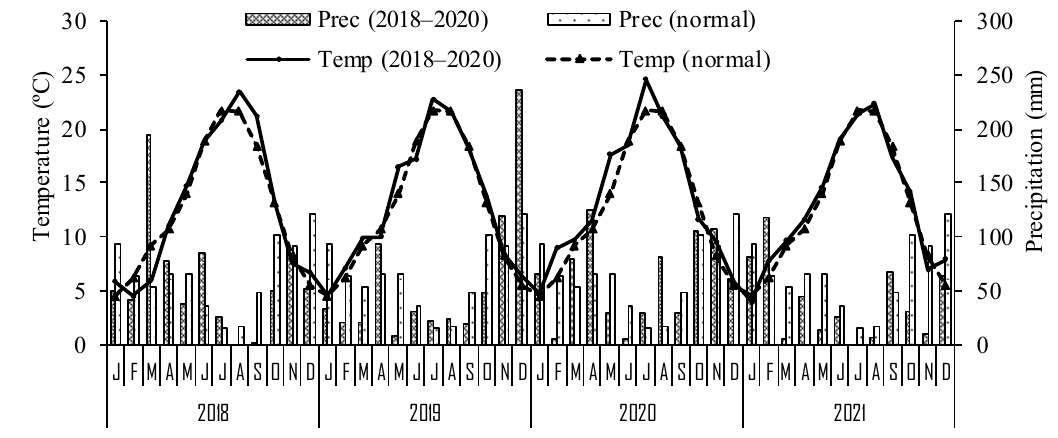
Figure 1. Average monthly temperature and accumulated monthly precipitation during the experimental period, and climatological normal values for the region.